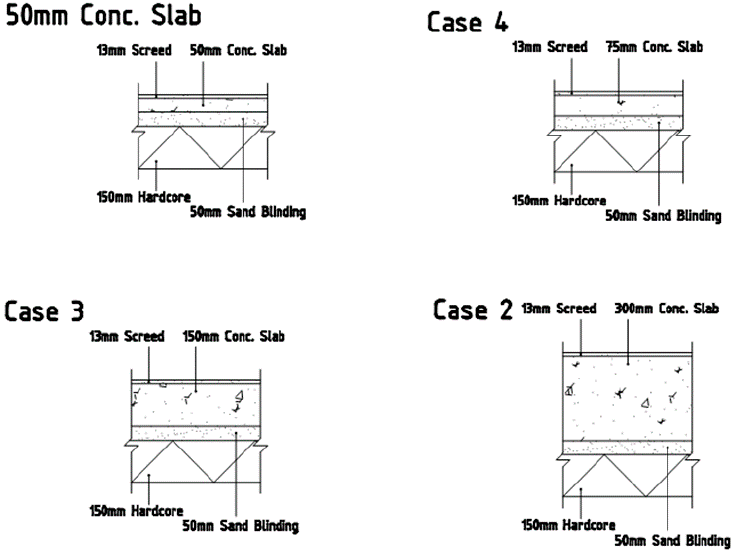
Figure A2. Floor envelope configuration.